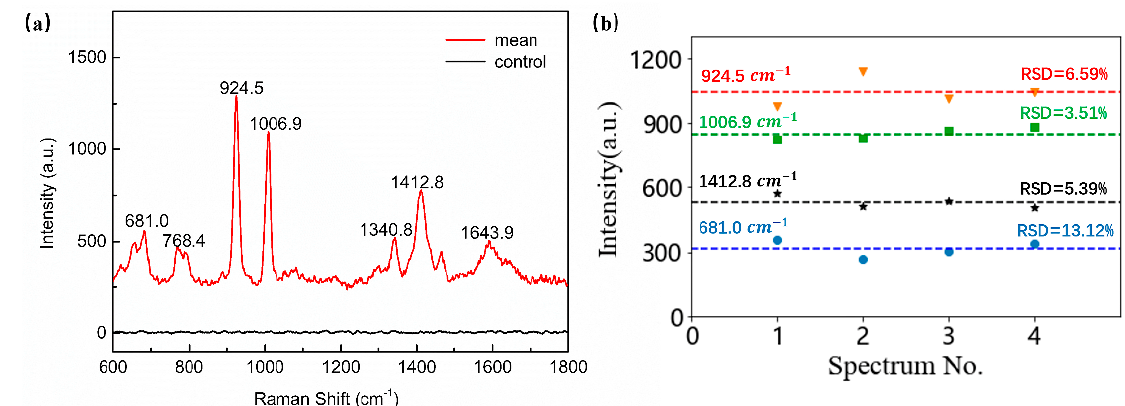
Figure 11. ( a ) The SERS spectra of plasmid DNA and the control group. ( b ) The intensity distributions of the 681.0, 924.5, 1006.9, and 1412.8 cm − 1 peaks of plasmid DNA in four randomly selected spots on the Ag/IPS, the dotted lines reveal the average intensities of each peak.